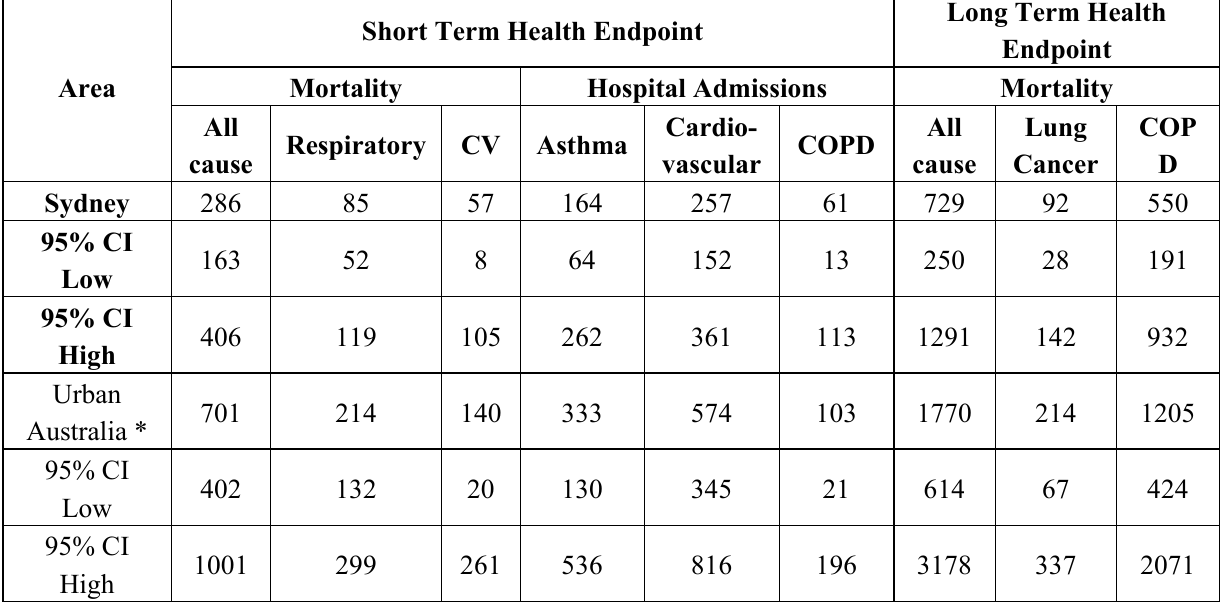
Table 2. Health effects (number of people affected) for 2006 attributable to levels of PM in